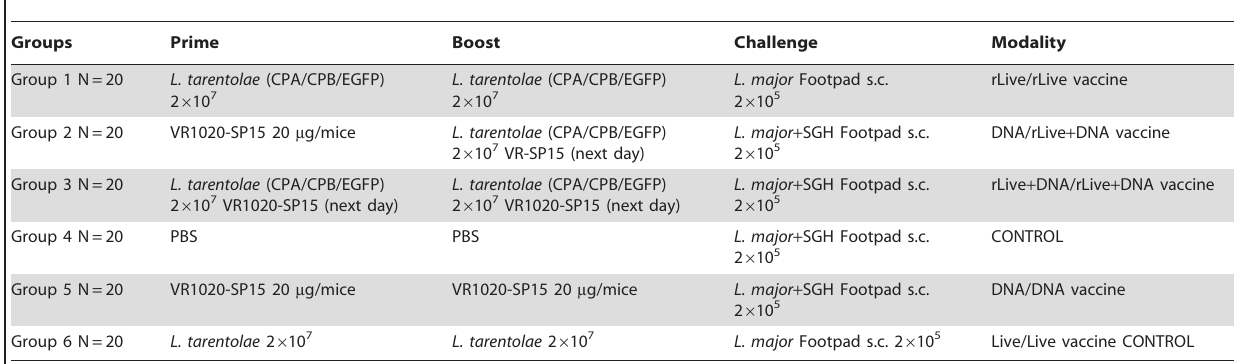
Table 1. Vaccination regimens in BALB/c and C57BL/6 mice models.